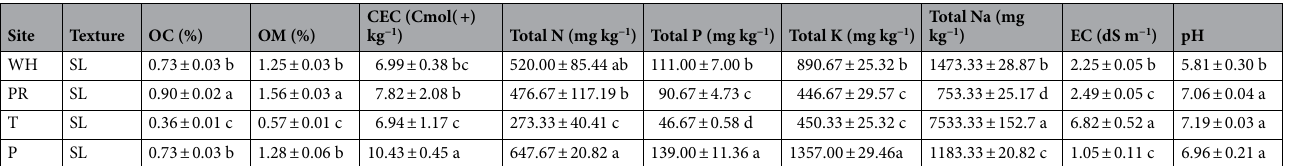
Table 1. Physical and chemical characteristics of rhizosphere soils of ‘RD 6’ rice cultivated in saline rice fields located in four areas in Khon Kaen province, Thailand. WH: Ban Wa; PR: Phra Yuen; T: Ban Thum; P: Ban Pai; OC: soil organic carbon; OM: soil organic matter; CEC: cation exchange capacity; N: nitrogen; P: phosphorus; K: potassium; Na: sodium; EC: electrical conductivity (soil–water 1:5); pH (soil–water 1:2); SL: sandy loam. Different letters in the same column represent significant differences at p < 0.05 according to LSD